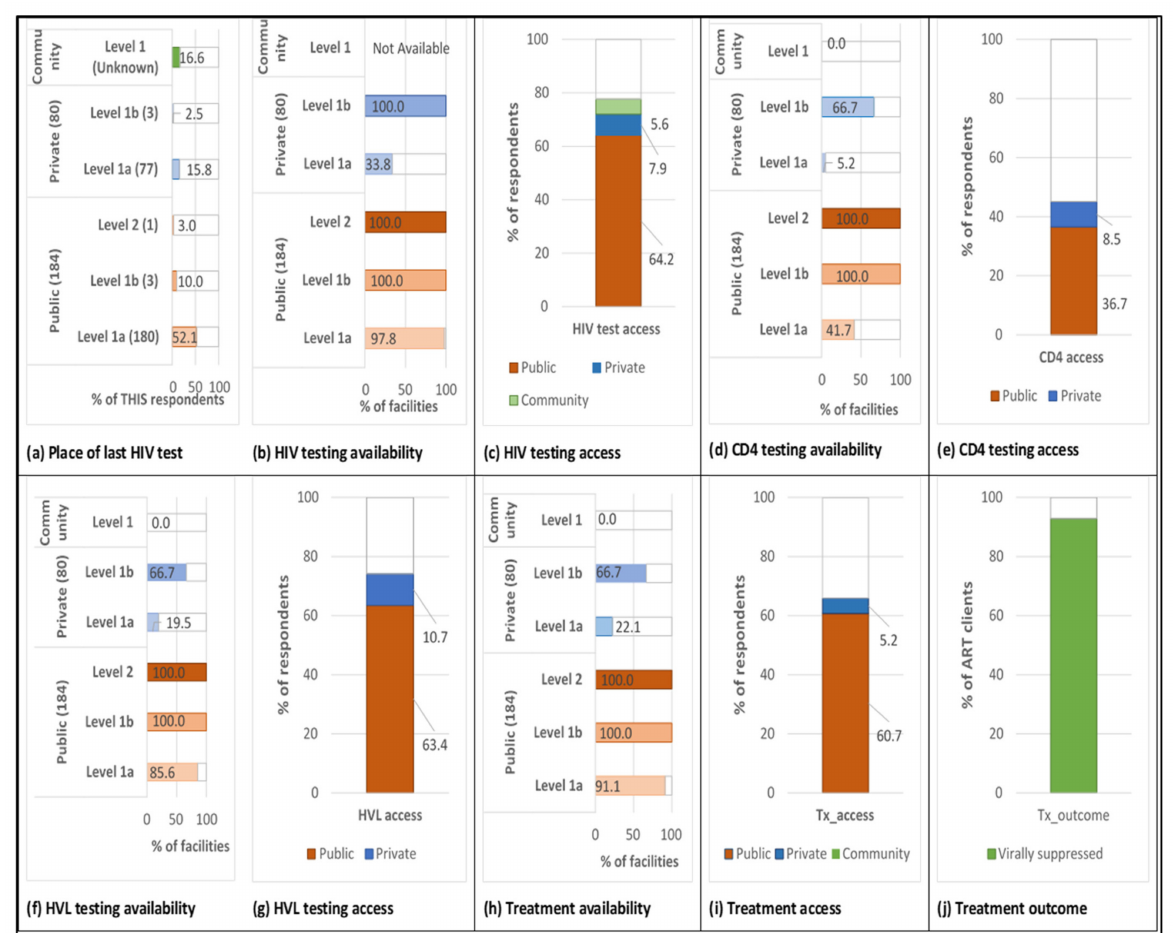
Figure 1. Patient-pathway analysis visual. ( a ) Number of facilities and place of last HIV test: Estimated number of facilities in each sector and proportion of respondents who had an HIV test within the last 1 year in the 2016–2017 Tanzania HIV Impact Survey (THIS); ( b ) HIV testing availability: % of facilities or community-based programmes with HIV testing services available obtained from Tanzania Health Facility Registry (HFR) and DHIS2 summary report; ( c ) HIV testing access: % of THIS respondents who tested for HIV in the public and private sector, by level; Testing availability ( d ) CD4 count and ( f ) HIV viral load): % of facilities with HIV diagnostic services (CD4 count and HIV viral load) available as obtained